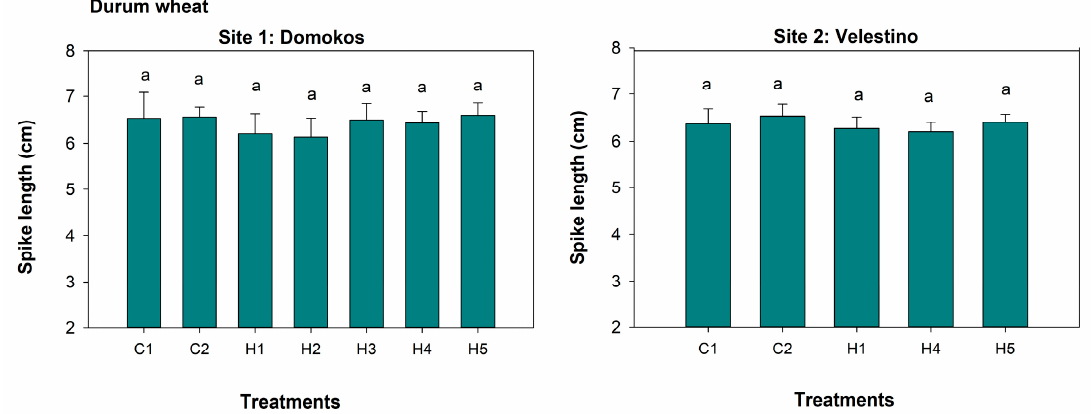
Figure 8. Herbicide treatment (C1: untreated control, C2: weed-free control, H1: metsulfuron-methyl + bensulfuron-methyl, H2: pyroxsulam/florasulam + 2,4-D, H3: aminopyralid + florasulam, H4: bromoxynil + 2,4-D, and H5: halauxifen-methyl + florasulam) effects on spike length (cm) at two sites. Values are presented as means of three replicates ± standard deviation. Mean values followed by different letters have statistically significant differences according to Duncan’s multiple range test at p < 0.05. F values of ANOVA: F = 0.749 ns (Site 1: Domokos) and F = 0.664 ns (Site 2: Velestino). ns = not significant.